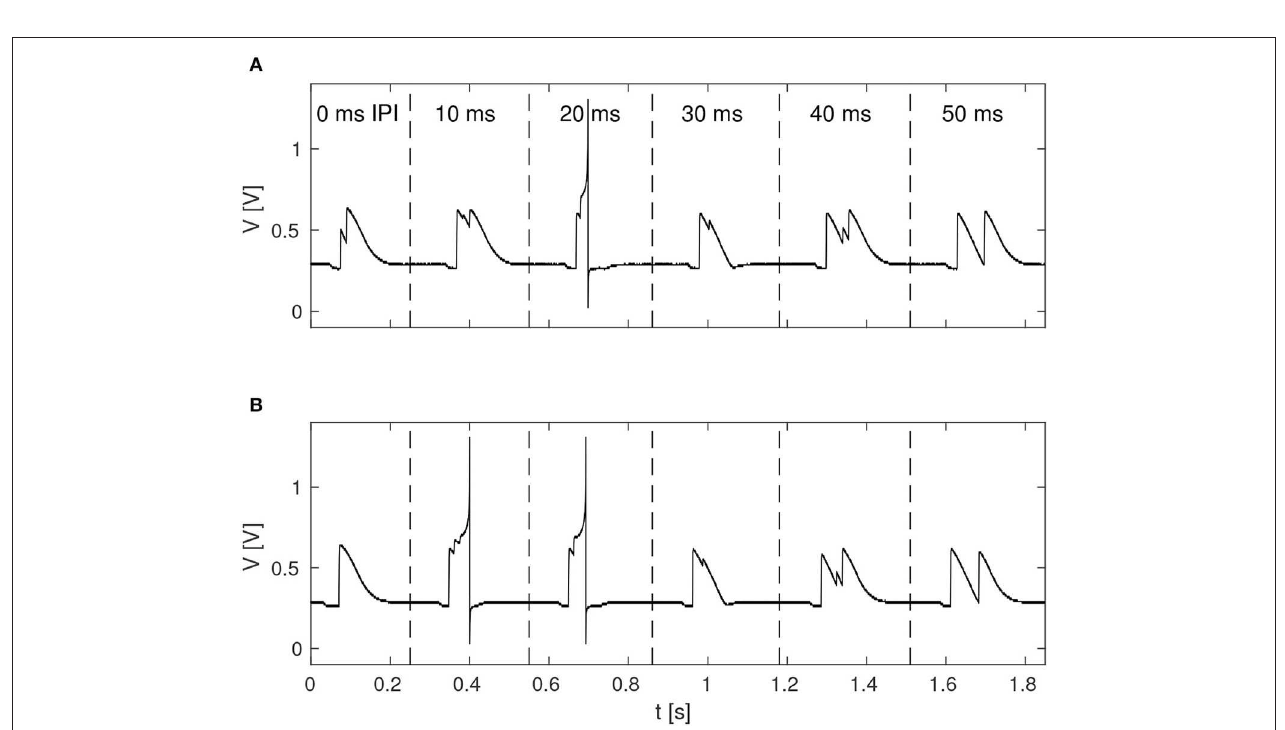
FIGURE 5 | Response of LN4 for double-pulse stimuli with IPIs of 0, 10, 20, 30, 40, and 50 ms, respectively. (A) Noiseless case. (B) Example for 20% noise, with a false positive for the 10-ms IPI.